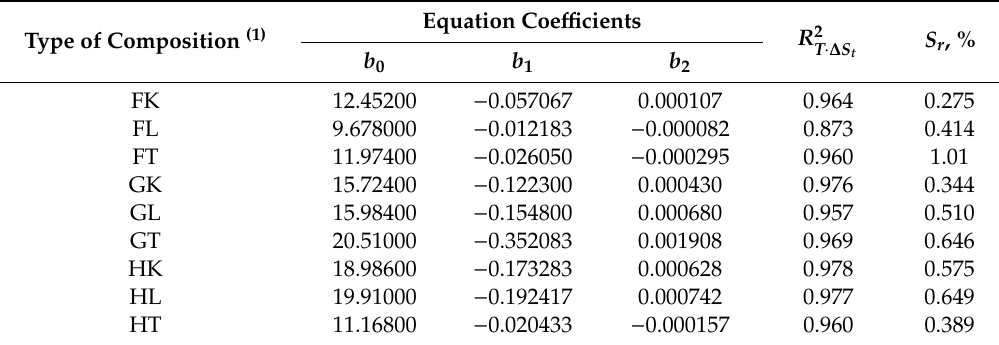
Table 5. Statistical data of swelling in thickness